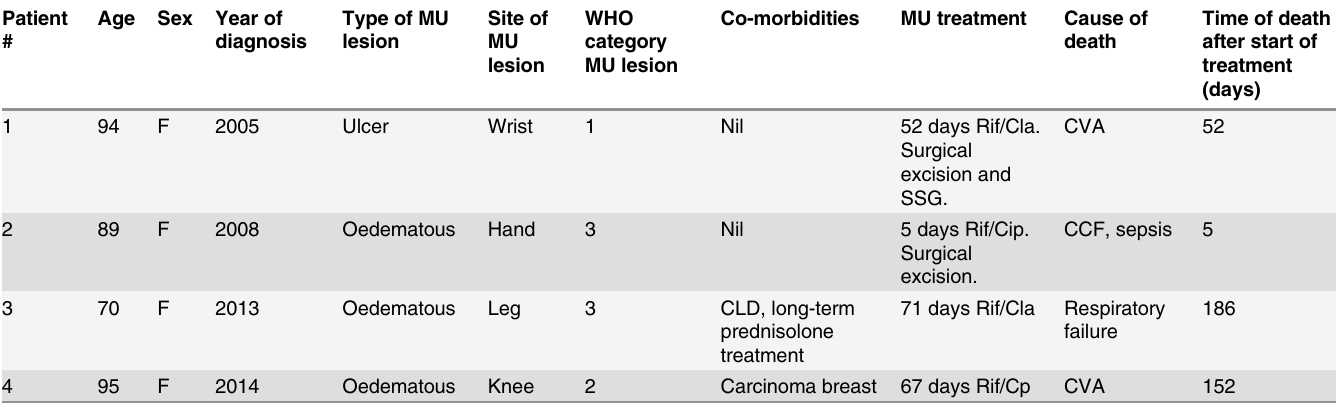
Table 4. Patient characteristics of those who died following commencement of MU treatment.